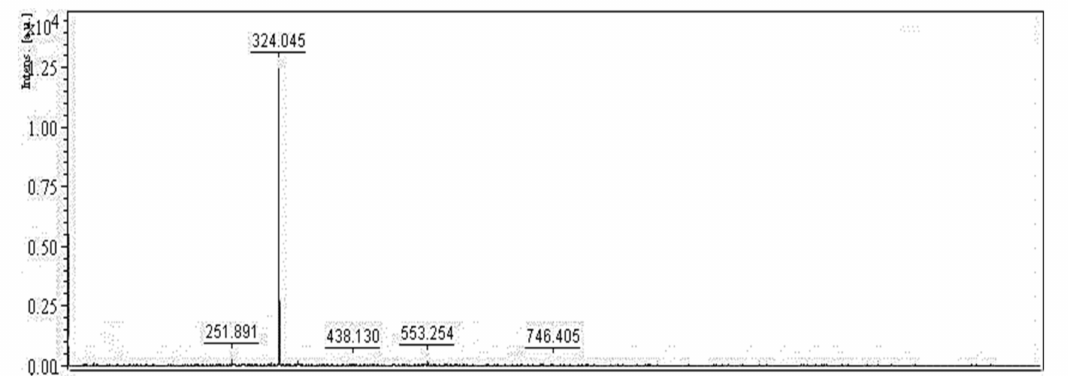
Figure 6. Mass of purified PG was detected by MALDI-TOF MS spectrum. A matrix, including 2,5-dihydroxybenzoic acid in TFA-H 2 O-CAN (0.1 / 50 / 50%, v / v / v , respectively) solution was used to